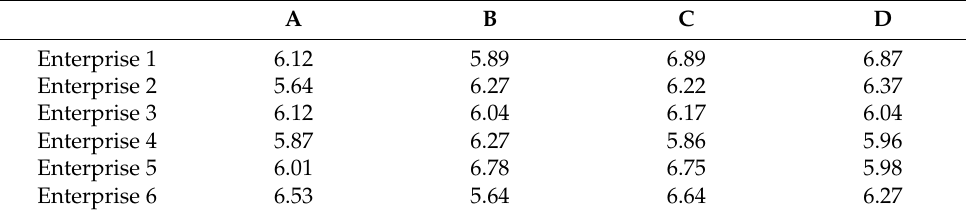
Table 7. Primary indicator values of the social effects of six enterprises’ carbon accounts.